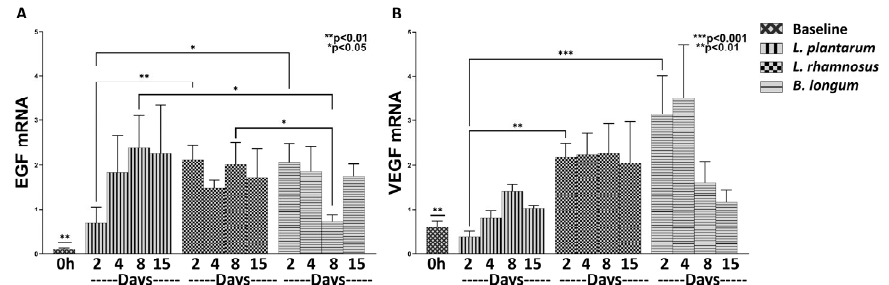
Figure 6. The effects of L. plantarum , L. rhamnosus and B. longum on angiogenesis. The mRNA ex ‐ pression of EGF ( A ) and VEGF ( B ) during the healing process. Results are presented as means with SEM. EGF Baseline: ** p < 0.01 compared to L. plantarum (Days 2–15), L. rhamnosus (Days 2–15) and B. longum (Days 2–15); VEGF Baseline: * p < 0.05 compared to L. plantarum (Day 8), L. rhamnosus (Days 2–15) and B. longum (Days